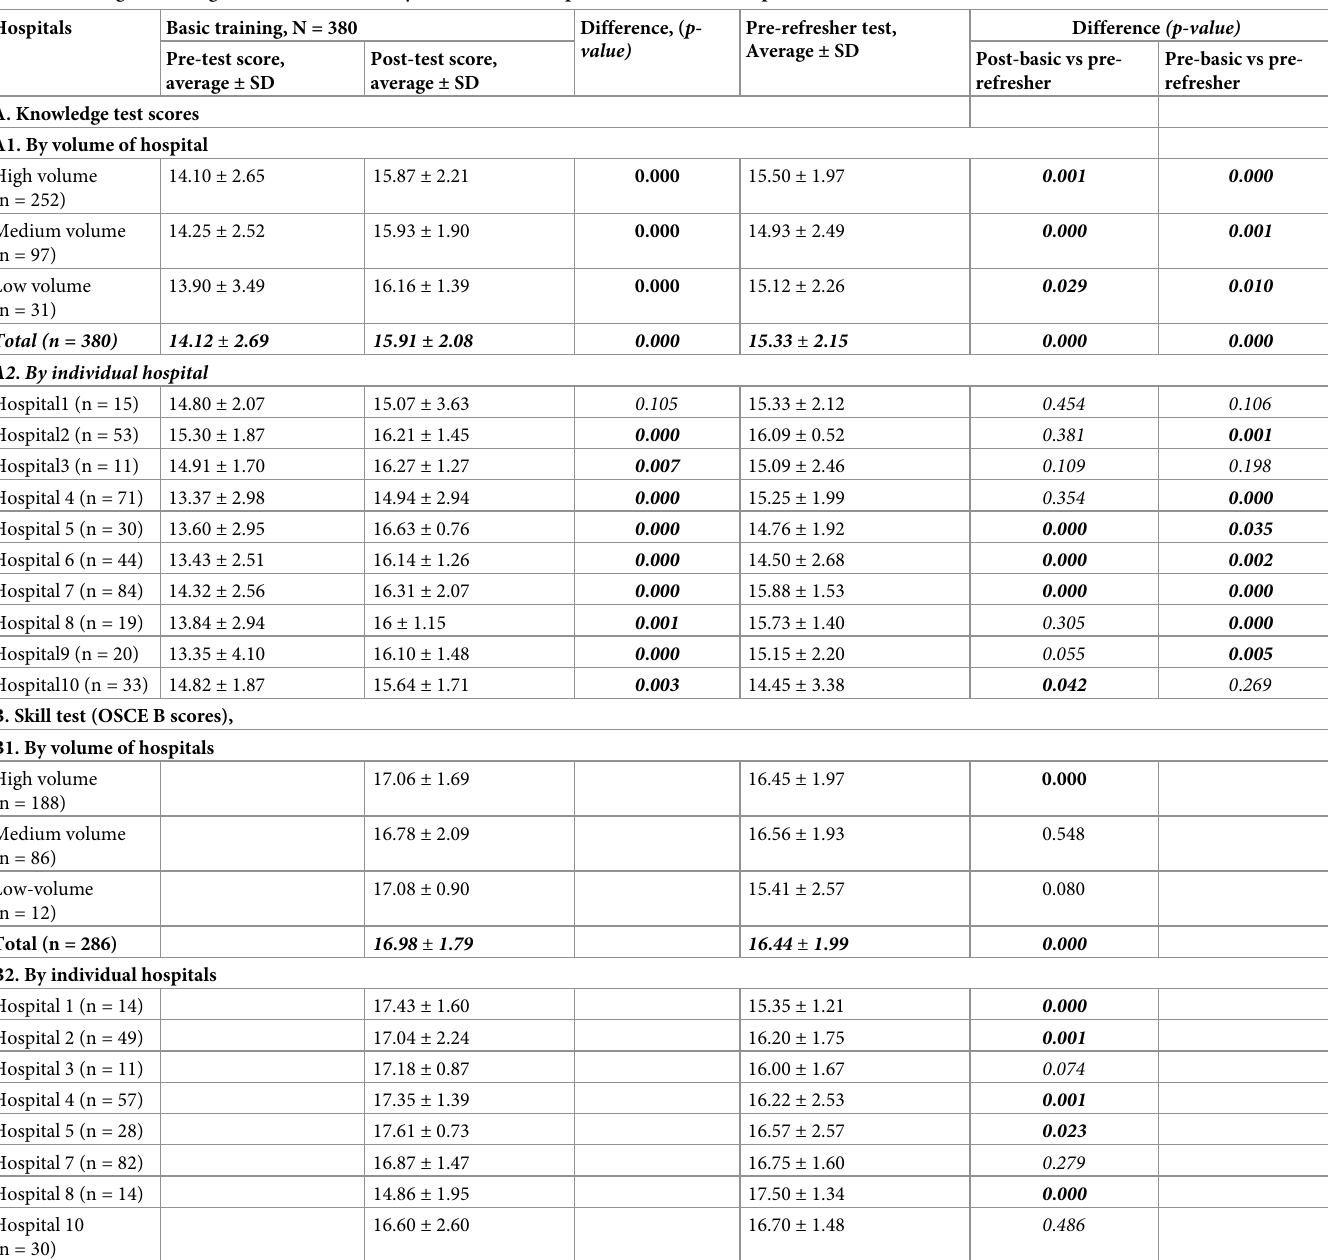
Table 2. Average knowledge and skill test scores by volume of the hospital and individual